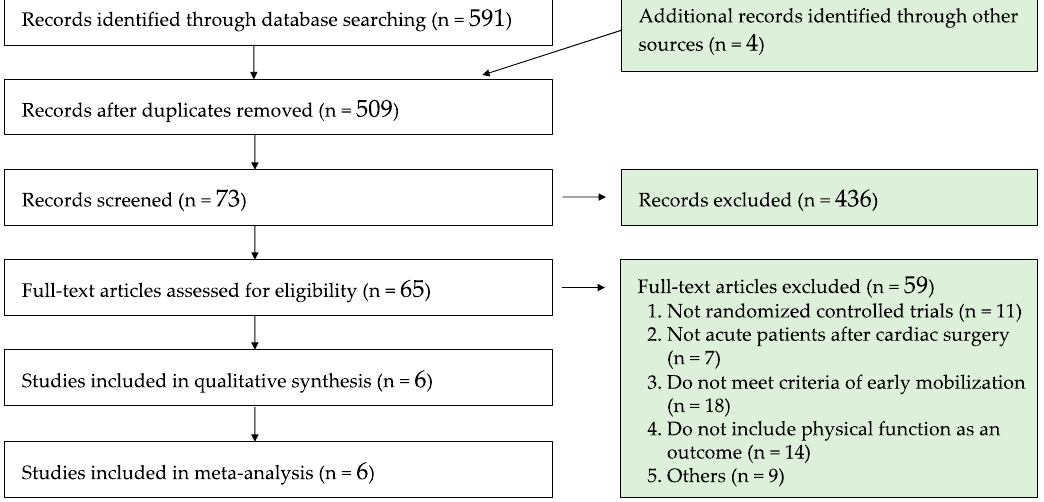
Figure 2. Flow diagram of study selection.